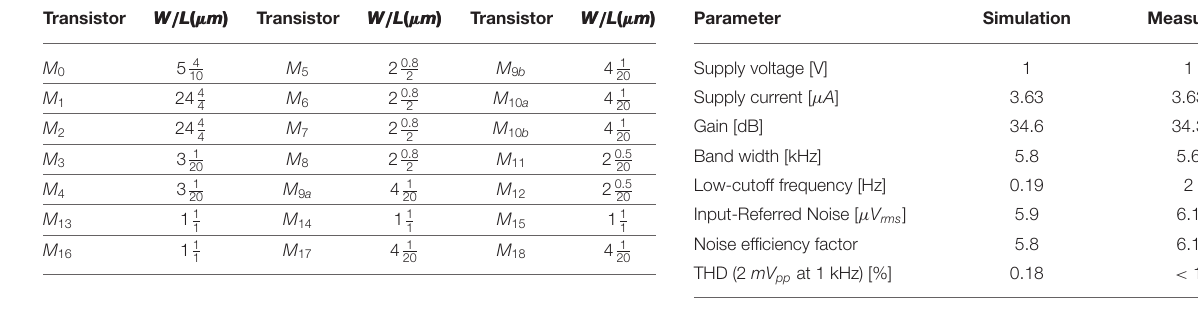
TABLE 2 | Bias currents of the neural amplifier.